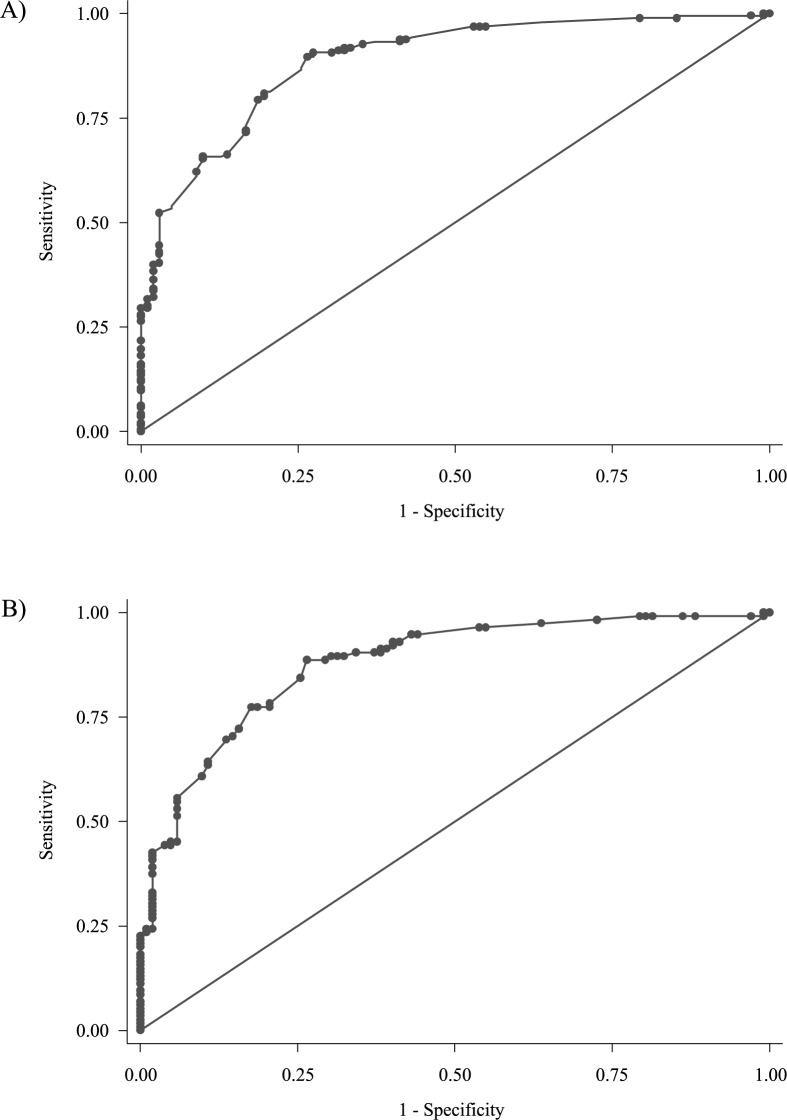
Receiver operating characteristics curves for colorectal cancer.Note. A) ROC curve for all stage CRC with a non-optimism corrected AUC of 0.8870. B) ROC curve for stage I and II CRC with a non-optimism corrected AUC of 0.8775. Receiver operating characteristics (ROC). Colorectal cancer (CRC). Area under the receiver operating characteristics curve (AUC).